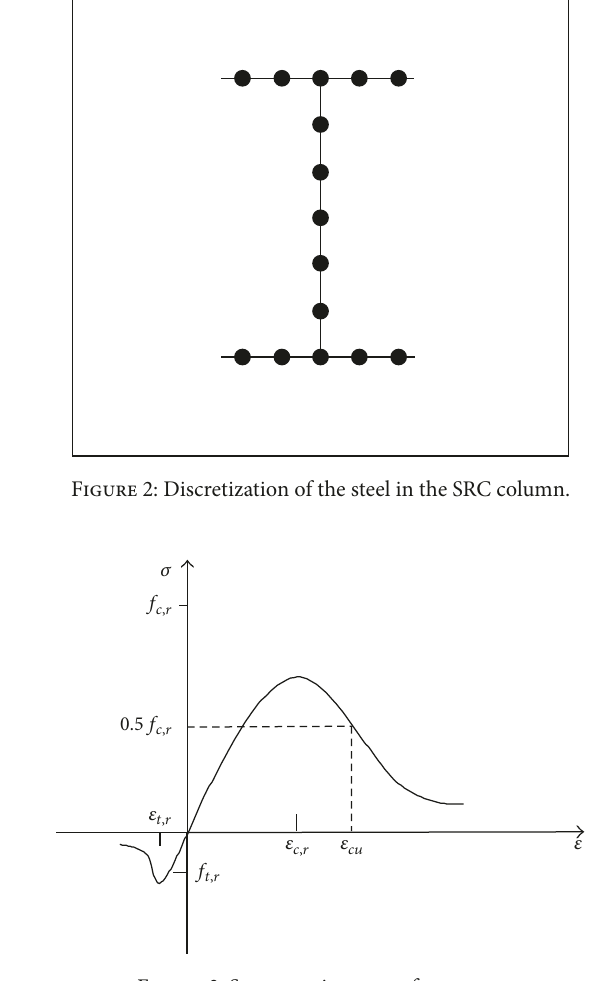
Figure 3: Stress-strain curve of